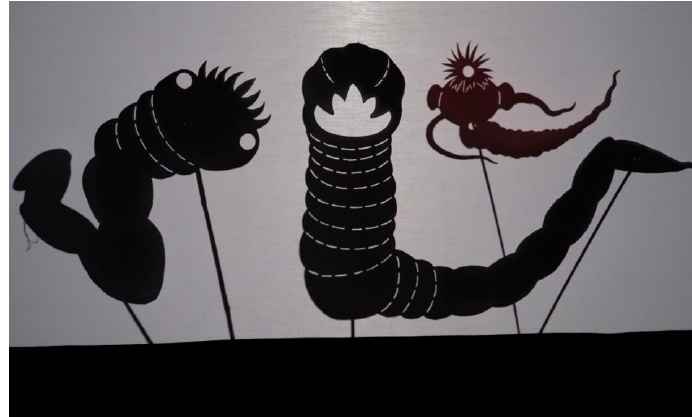
Figure 2. Soil-transmitted helminths represented in the ‘Rama and the Worm’ shadow puppet production.